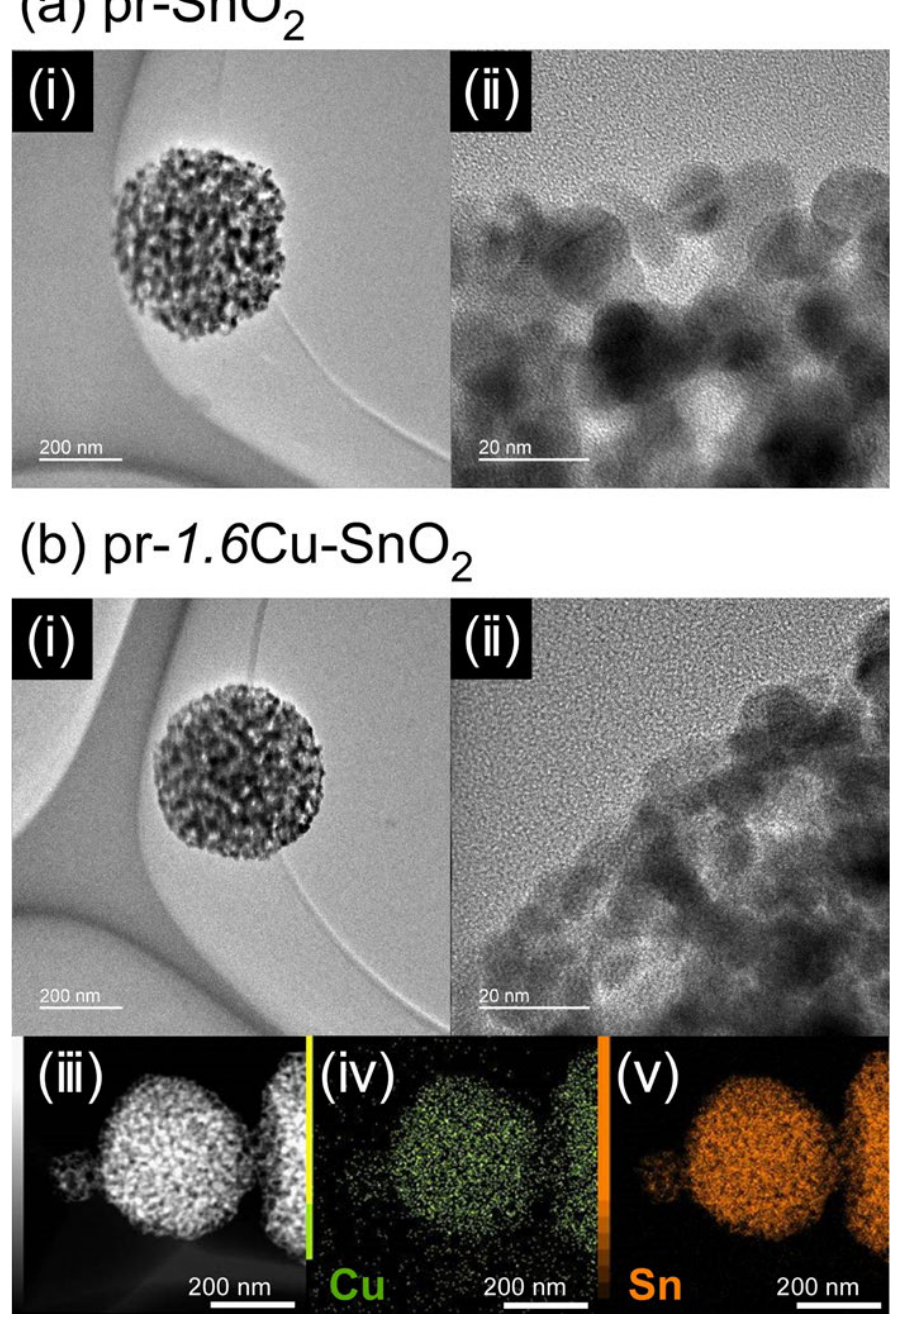
Figure 3. TEM photographs of as-prepared ( a ) (i,ii) pr-SnO 2 and ( b ) (i,ii) pr- 1.6 Cu-SnO 2 powders. STEM photograph of as-prepared pr- 1.6 Cu-SnO 2 powders (( b ) (iii)) and their EDS elemental map- pings (( b ) (iv): Cu and ( b ) (v): Sn). ders. STEM photograph of as-prepared pr- 1.6 Cu-SnO 2 powders (( b ) ( iii )) and their EDS elemental mappings (( b ) ( iv ): Cu and ( b ) ( v ):